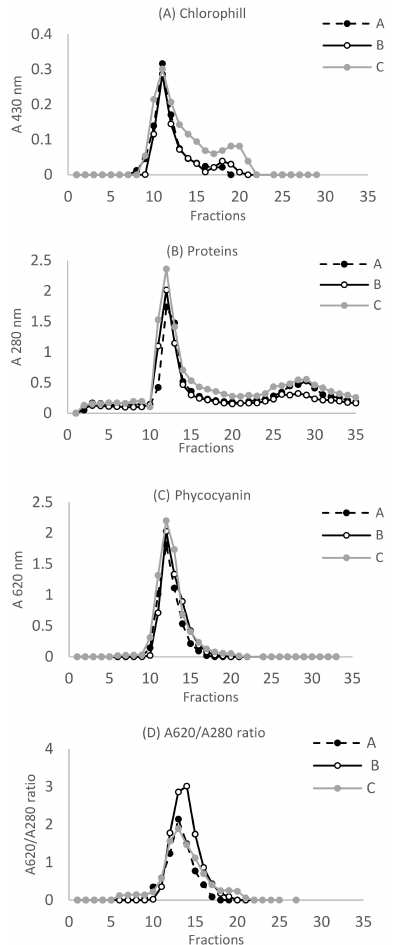
Figure 3. Chromatographic pattern after size exclusion chromatography of extracts A, B, and C obtained from samples grown at 1, 5, and 10 mg Fe L − 1 , respectively. ( A ) Chlorophyll a was detected at 430 nm; ( B ) total proteins were measured at 280 nm; ( C ) phycocyanin was measured at 620 nm; ( D ) the purity of phycocyanin was determined by the ratio absorbance at 620 nm/absorbance at 280 nm. Each chromatogram is the mean of two independent